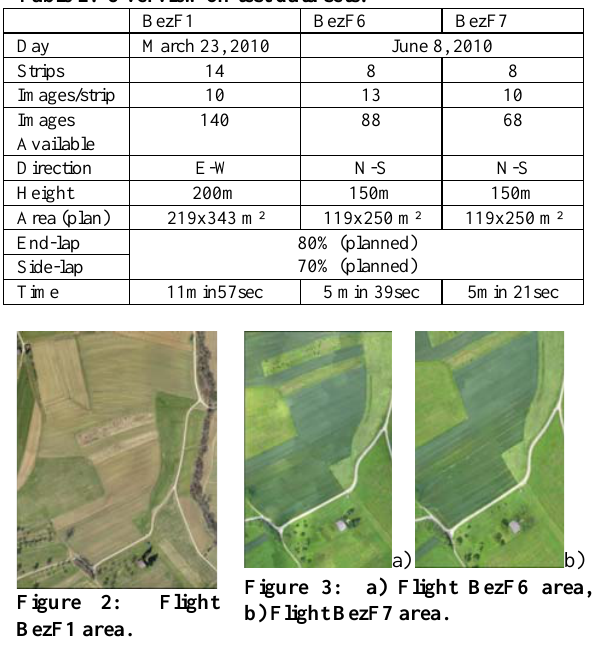
Table 2: Overview on test data sets.